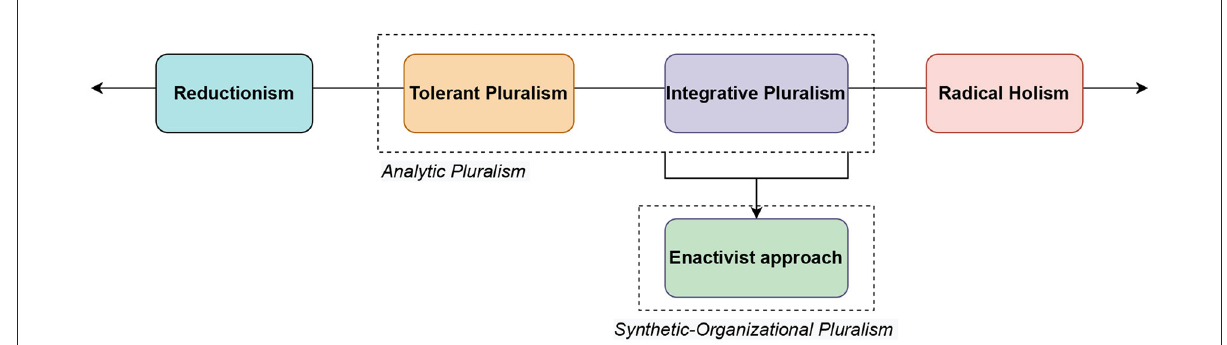
FIGURE1 A continuum of explanatory perspectives in psychiatry from reductionism (i.e., reduction of a set of explanations to a single explanation) toward radical holism (i.e., unweighted acceptance of all explanatory perspectives). Integrative and tolerant pluralisms lie between these two poles. Enactive approaches constitute one kind of integrative pluralism, a synthetic-organizational